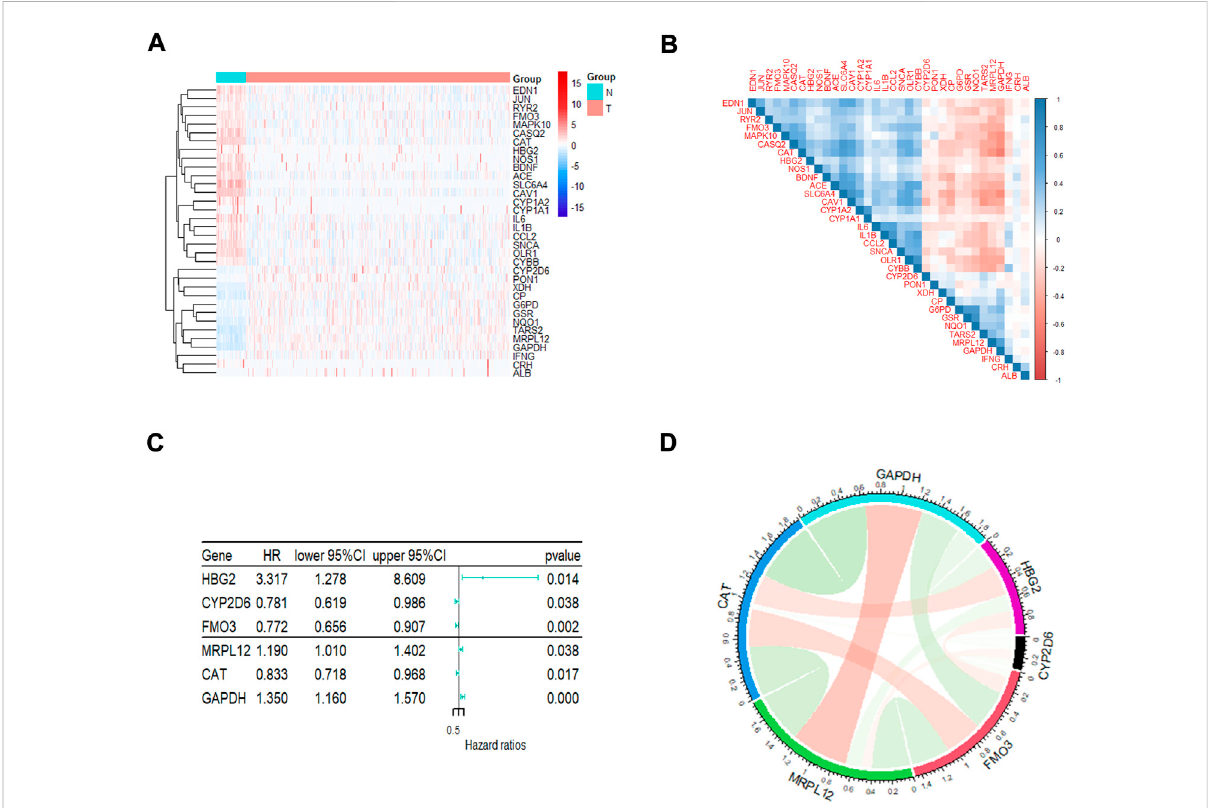
FIGURE 1 TheanalysisofoxidativestressgenesrelatedtoprognosisinLUAD. (A) Theheatmapvisualizestheexpressionofoxidativestressrelatedgenesin LUAD. Blue represents low expression while red represents high expression. N represents normal samples and T represents tumor samples. (B) Correlation analysis of oxidative stress related genes in LUAD. (C) Univariate Cox regression analysis of different oxidative stress genes related to prognosis. (D) The correlation of screened genes from regression